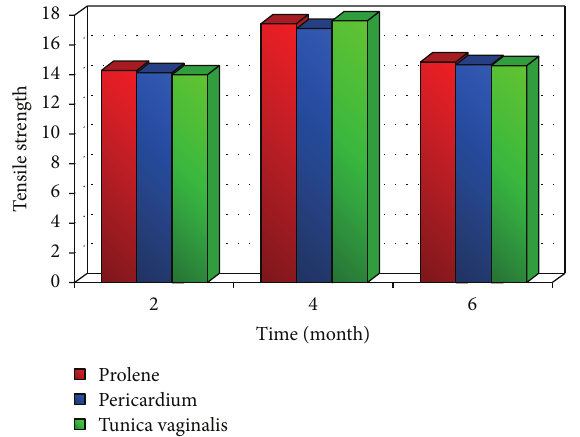
Figure 2: Tensile strength of prolene, pericardium, and tunica vaginalis at different times [33].